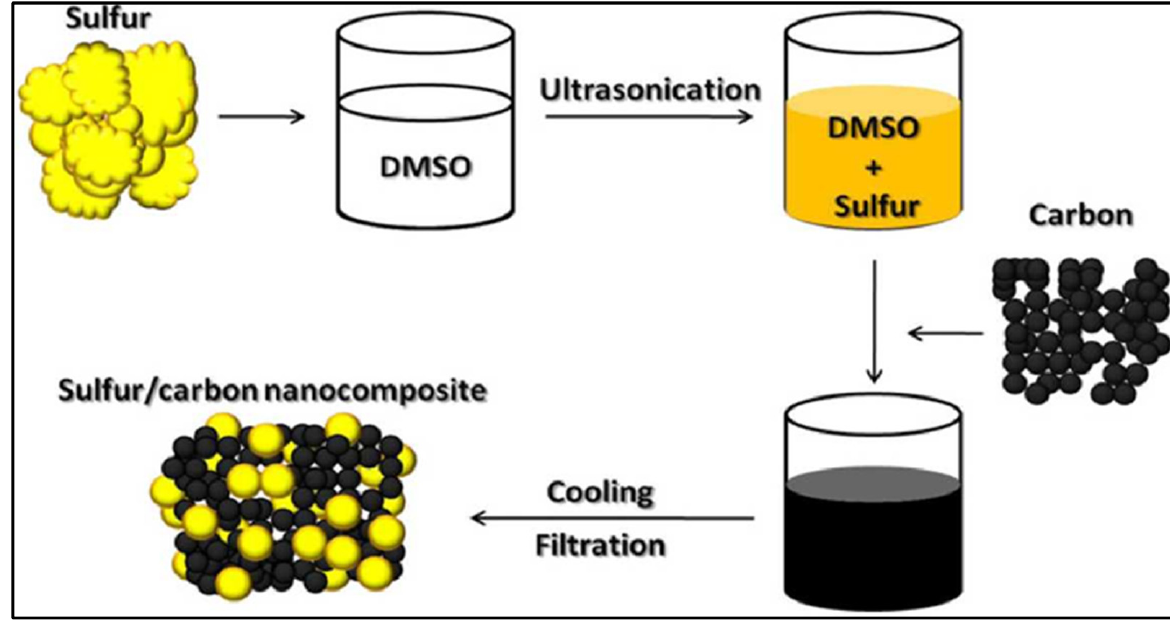
Figure 6. The synthesis process of sulfur nanoparticles [140].